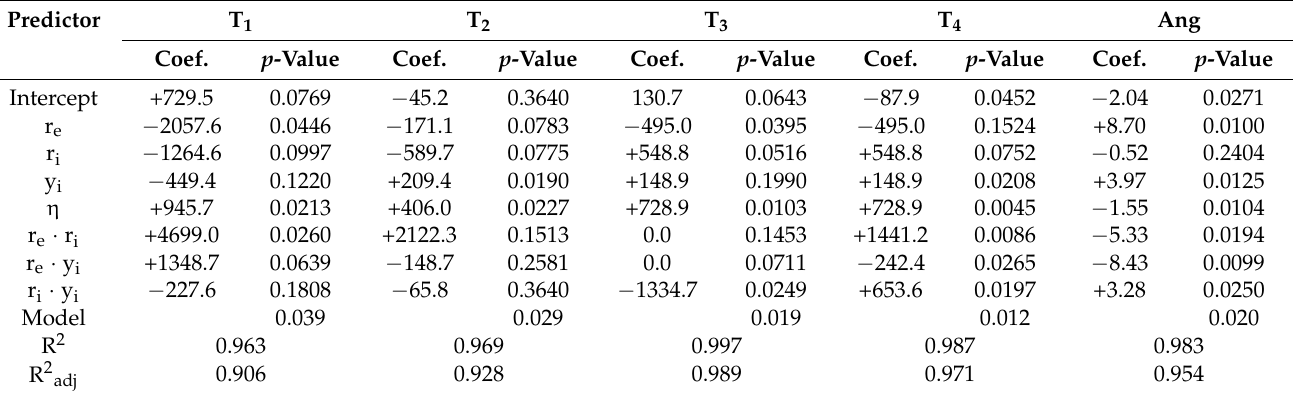
Table 6. ANOVA of the regression